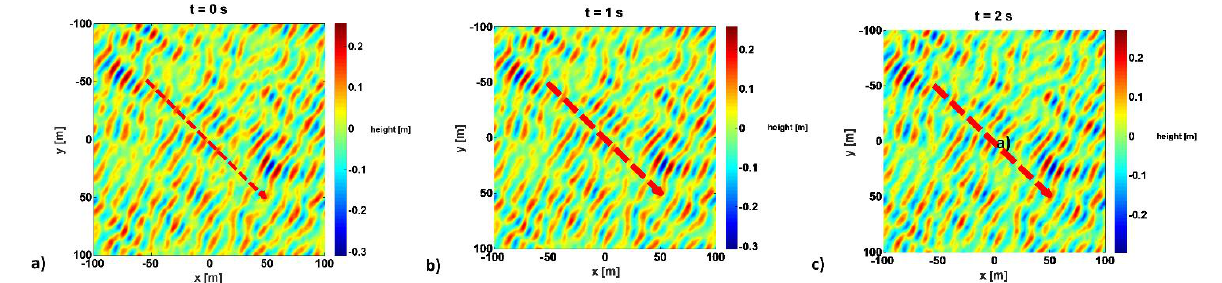
Figure 3. Three sea surface snap-shots for times ( a ) 0 s, ( b ) 1 s and ( c ) 2 s. Note that waves “propagate” and disperse while travelling along φ = 45° with respect to the y axis (looking direction). Colorbar indicates the sea surface height in